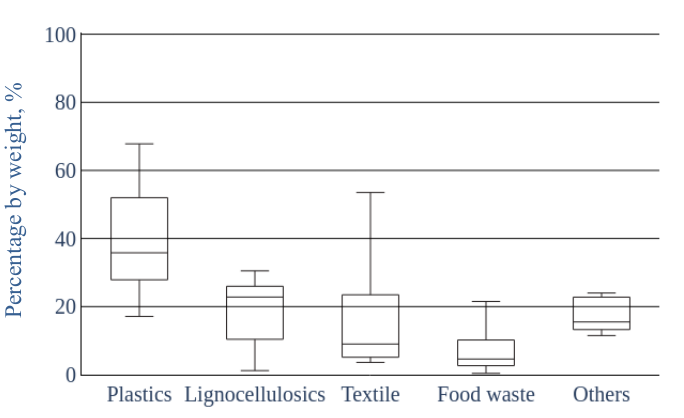
Fig. 1. Composition of used